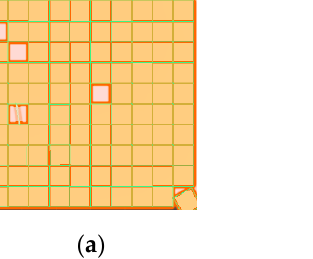
Figure 10. Simulation of falling ceiling tiles, ( a ) the separated tiles at DS1; ( b ) final status of falling tiles.